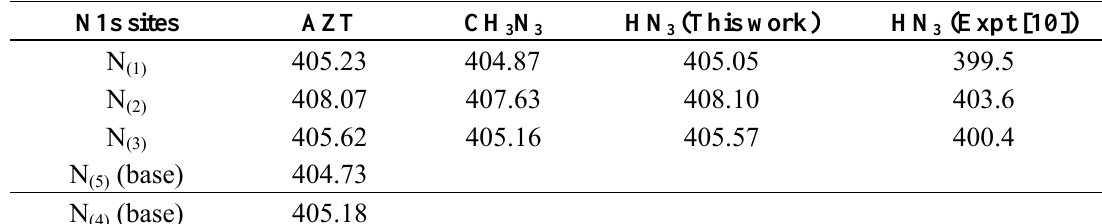
, CH N and AZT in the inner-shell 3 3 3